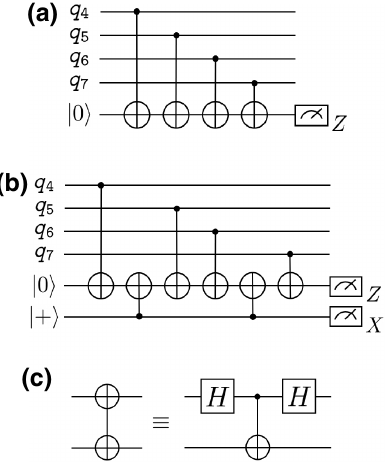
FIG. 1. (a) An example of a nonflag circuit for measuring gen- erator g z of the [[7, 1, 3]] code. Only qubits on which the operator 1 acts are displayed. The measurement results 0 and 1 obtained from the syndrome ancilla correspond to the + 1 and − 1 eigen- . (b) An example of a flag circuit for measuring g z values of g z 1 The state of the flag ancilla can flip from |+(cid:2) to |−(cid:2) if some fault occurs in between two flag CNOT gates. A circuit for measuring an X -type generator can be obtained by replacing each CNOT gate with the gate shown in